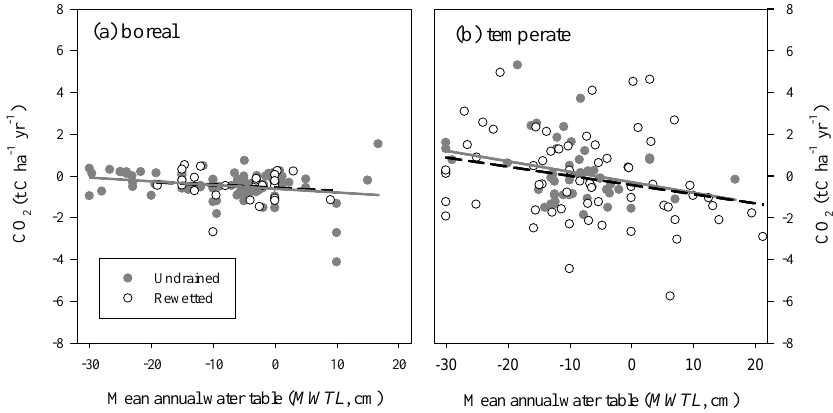
Figure 1. Relationship between annual carbon dioxide (CO 2 ) flux (t C ha -1 yr -1 ) and mean water table level ( MWTL , cm) for undrained and rewetted organic soils in (a) boreal and (b) temperate climate zones. Solid grey and dashed lines are the regression lines for the undrained and rewetted sites respectively. Regression equations and parameters are shown in Table 1. Negative MWTL indicates mean water table level below the soil surface and positive MWTL indicates mean water table above the soil surface. Negative CO 2 values indicate annual CO 2 removals and positive values indicate annual CO 2 emissions.